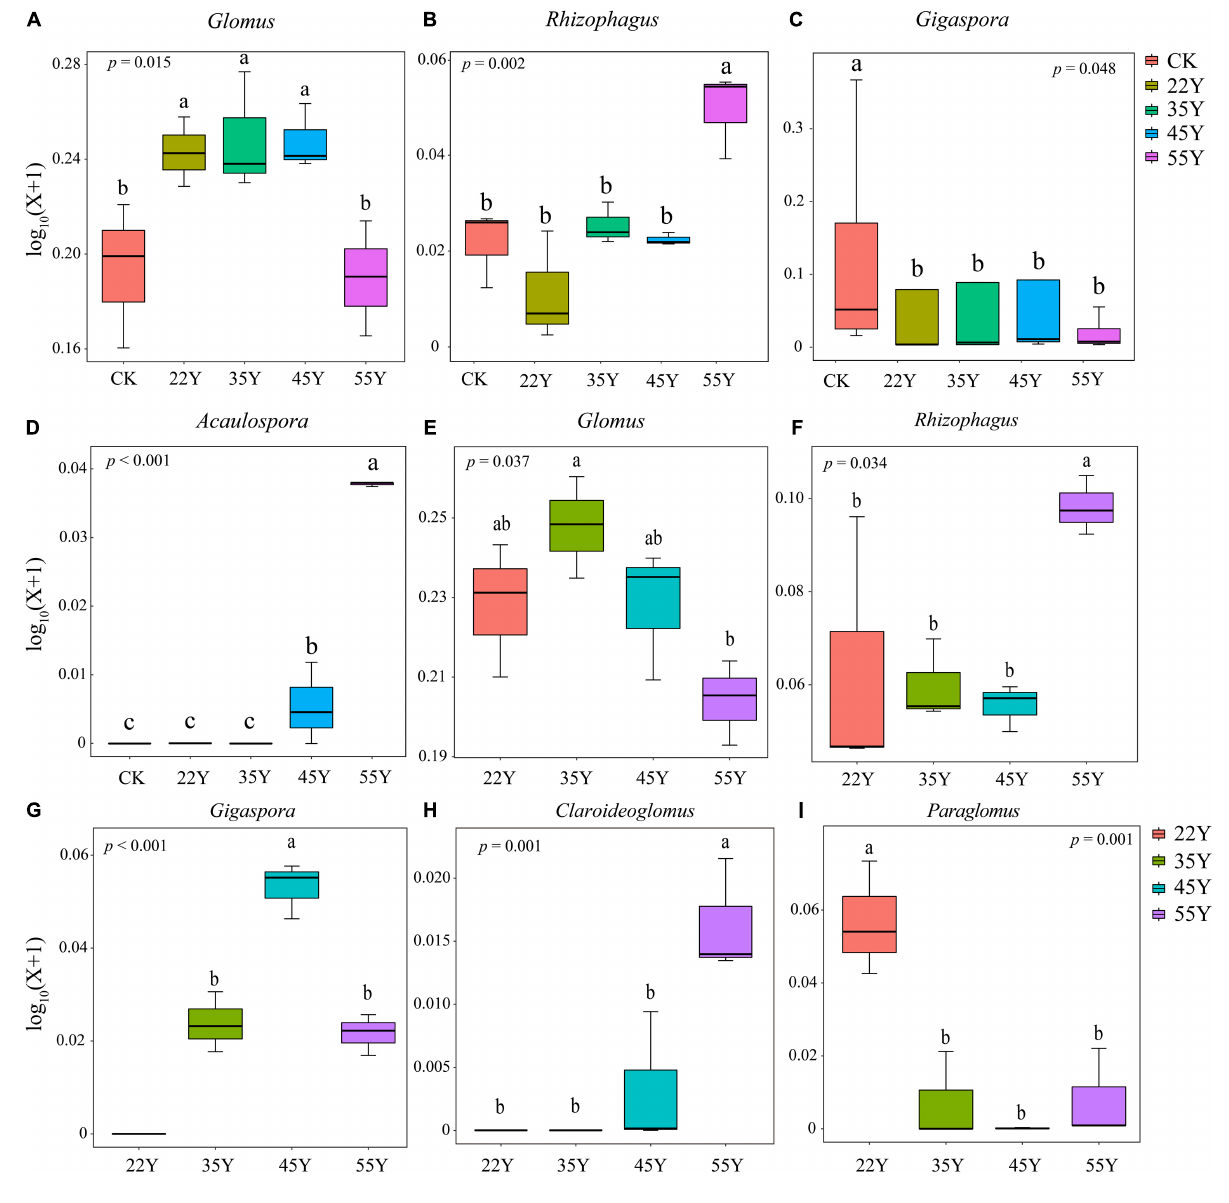
FIGURE 5 | The relative abundance of AM fungal genus in the root (A–D) and the rhizosphere soil (E–I) . Lowercase letters indicate significant differences among different stand ages ( P < 0.05). 22Y, 22-year stand; 35Y, 35-year stand; 45Y, 45-year stand; 55Y, 55-year stand; CK,